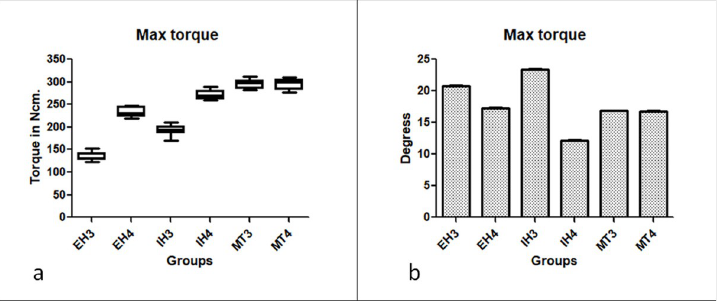
Fig 3. (a) Graph of the data of torque maximum supported in each group; (b) Bar graph of the rotation angle measured until the maximum torque was reached.